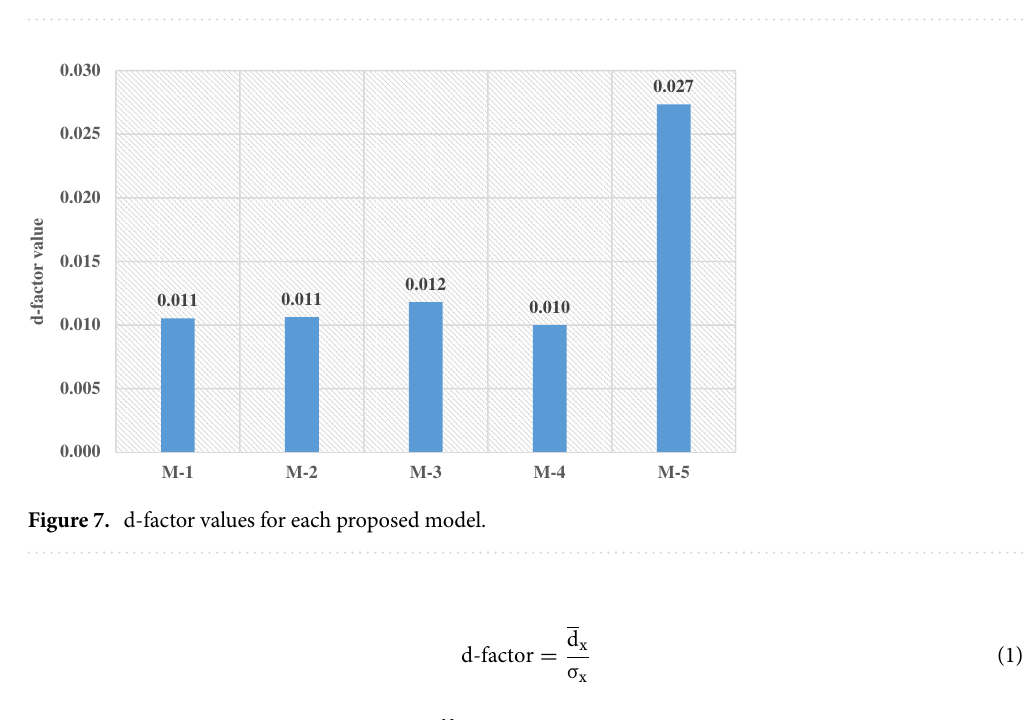
Figure 6. Violin plot between actual and proposed models.